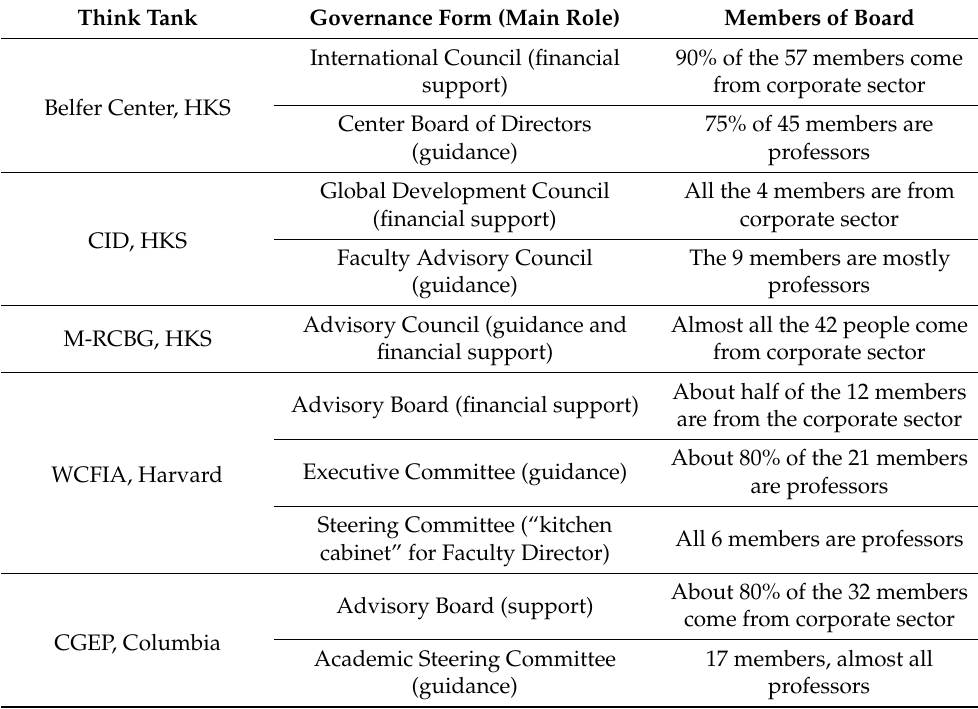
Table 4. The governance of the Ivy League think tanks (take the think tanks at Harvard and Columbia as a